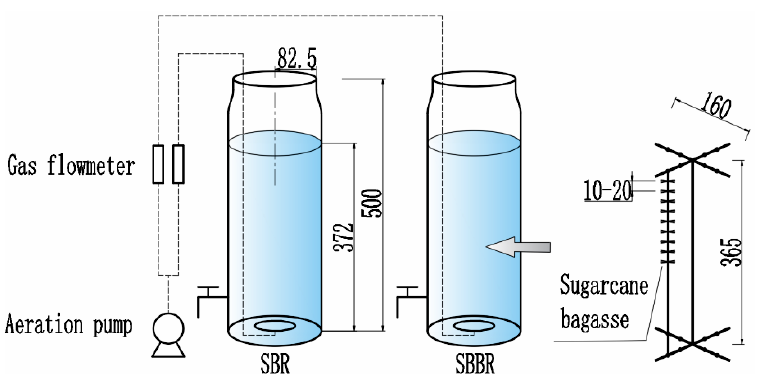
Figure 1. Schematic of sequencing batch reactor (SBR) and sequencing batch bioreactor (SBBR) loaded with sugarcane bagasse to evaluate the suitability of bagasse for aerobic denitrification. Note: The unit of size in this figure is mm.